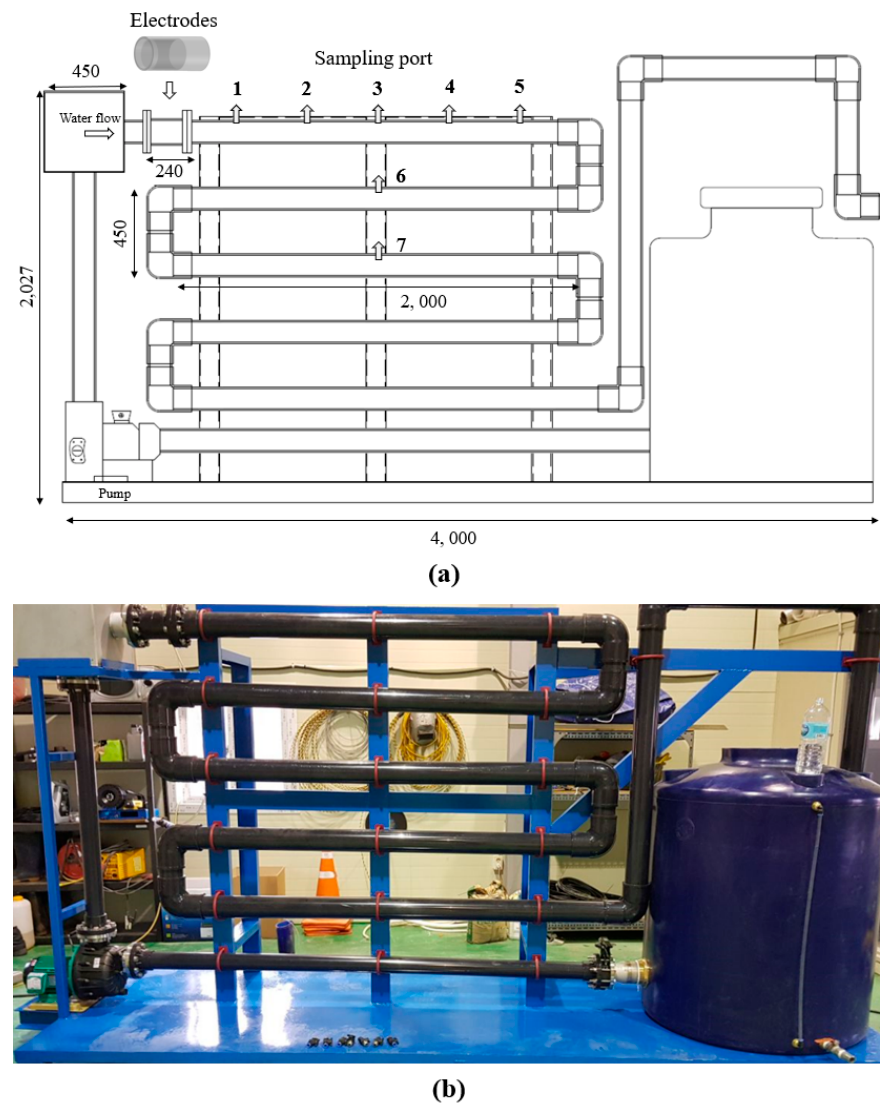
Figure 2. Schematic diagram for pilot-scale cooling-water circulation system ( a ) along with a real picture of the system ( b ).